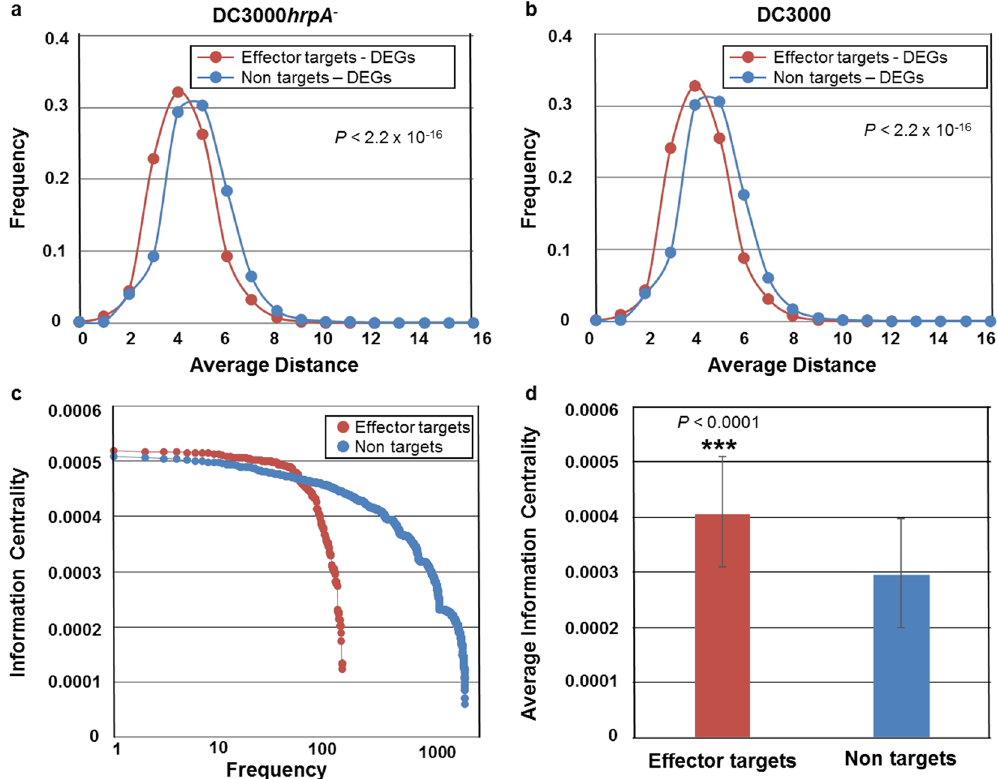
Figure 1. Measurement of diverse centrality parameters for effector targets. ( a and b ) Distribution of shortest path for pairs of effector targets and differentially expressed genes (DEGs) (magenta), and non effector targets and DEGs pairs (blue) for DC3000 hrpA − ( a ) and DC3000 ( b ). (Chi-Square Test of Independence; P < 2.2 × 10 − 16 ). ( c ) Distribution of information centrality for effector targets (magenta) and non targets (blue) in AI- MAIN . Frequency of occurrences of information centrality for both categories are depicted. (Student’s t -test P < 0.0001). ( d ) Average information centrality for effector targets (magenta) and non targets (blue) in AI- MAIN is displayed. (Student’s t -test P <